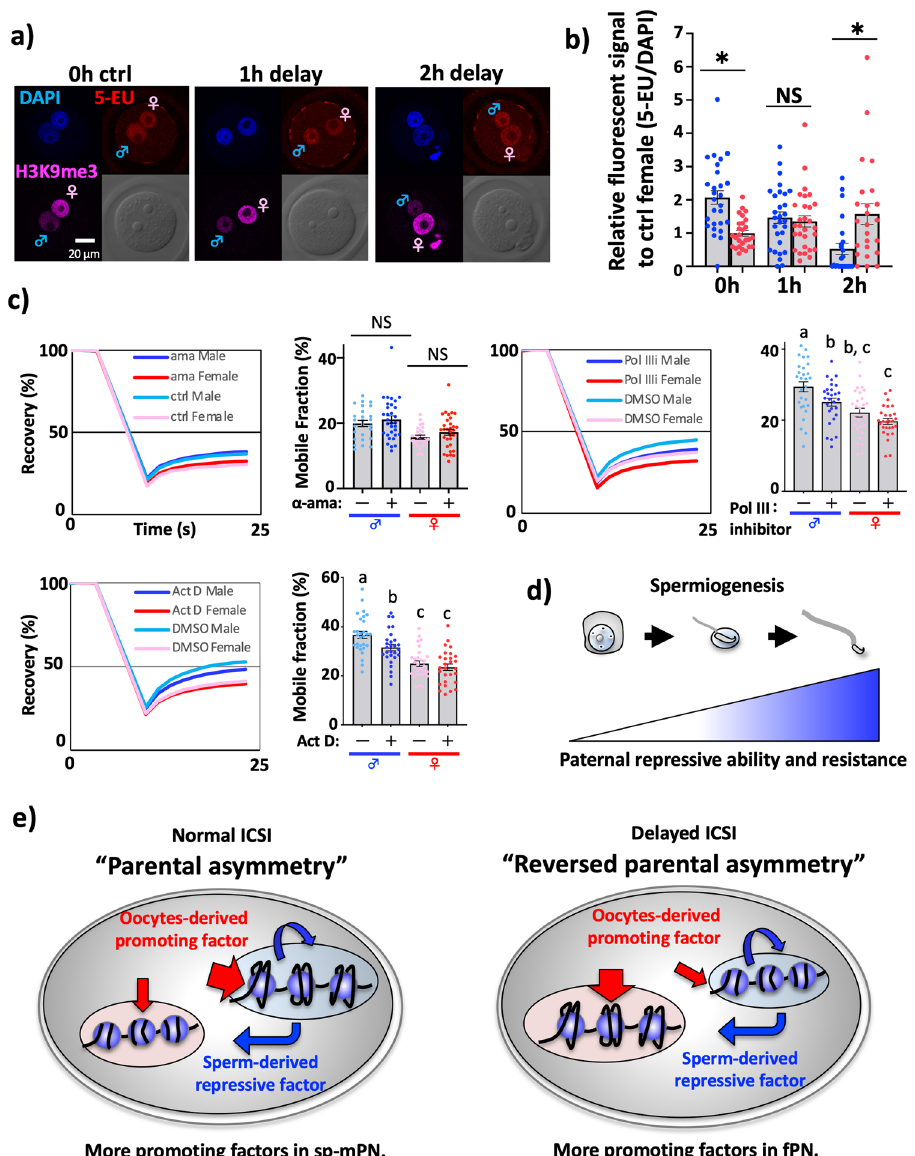
Fig. 3 Chromatin dynamics play a regulatory role for the establishment of parental asymmetric transcriptional activity. a Fluorescence images of 5-EU incorporation in delay ICSI-zygotes were shown. b Relative fl uorescent signals were shown in the bar graph. Asterisks show signi fi cant differences by paired t -test. n = 27, 29, 24, respectively. c The average Recovery curve and MF scores of IVF- zygotes treated with 100- µ g/ml α -amanitin, 0.1- µ g/ml Act. D, 20- µ M Pol IIIi and control zygotes were treated with 1 (Act. D) or 0.1% (Pol IIIi) dimethyl sulfoxide (DMSO) were shown. Treatment with